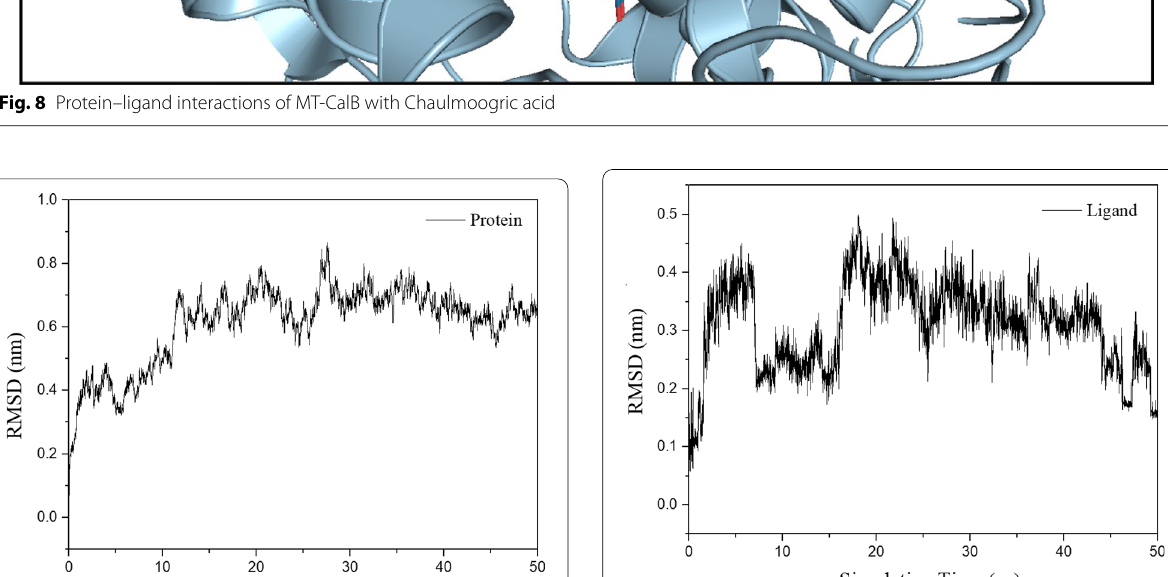
Fig. 10 RMSD of the